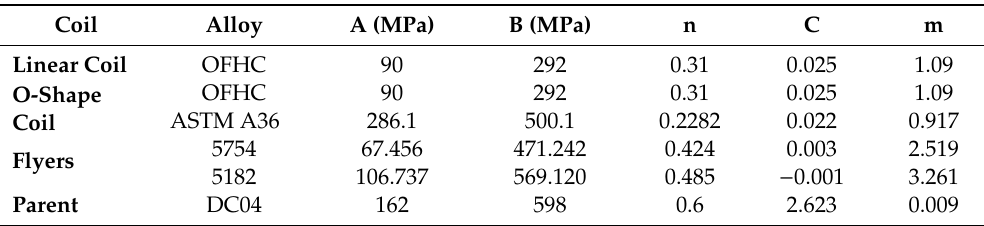
Table 6. Johnson–Cook model parameters.